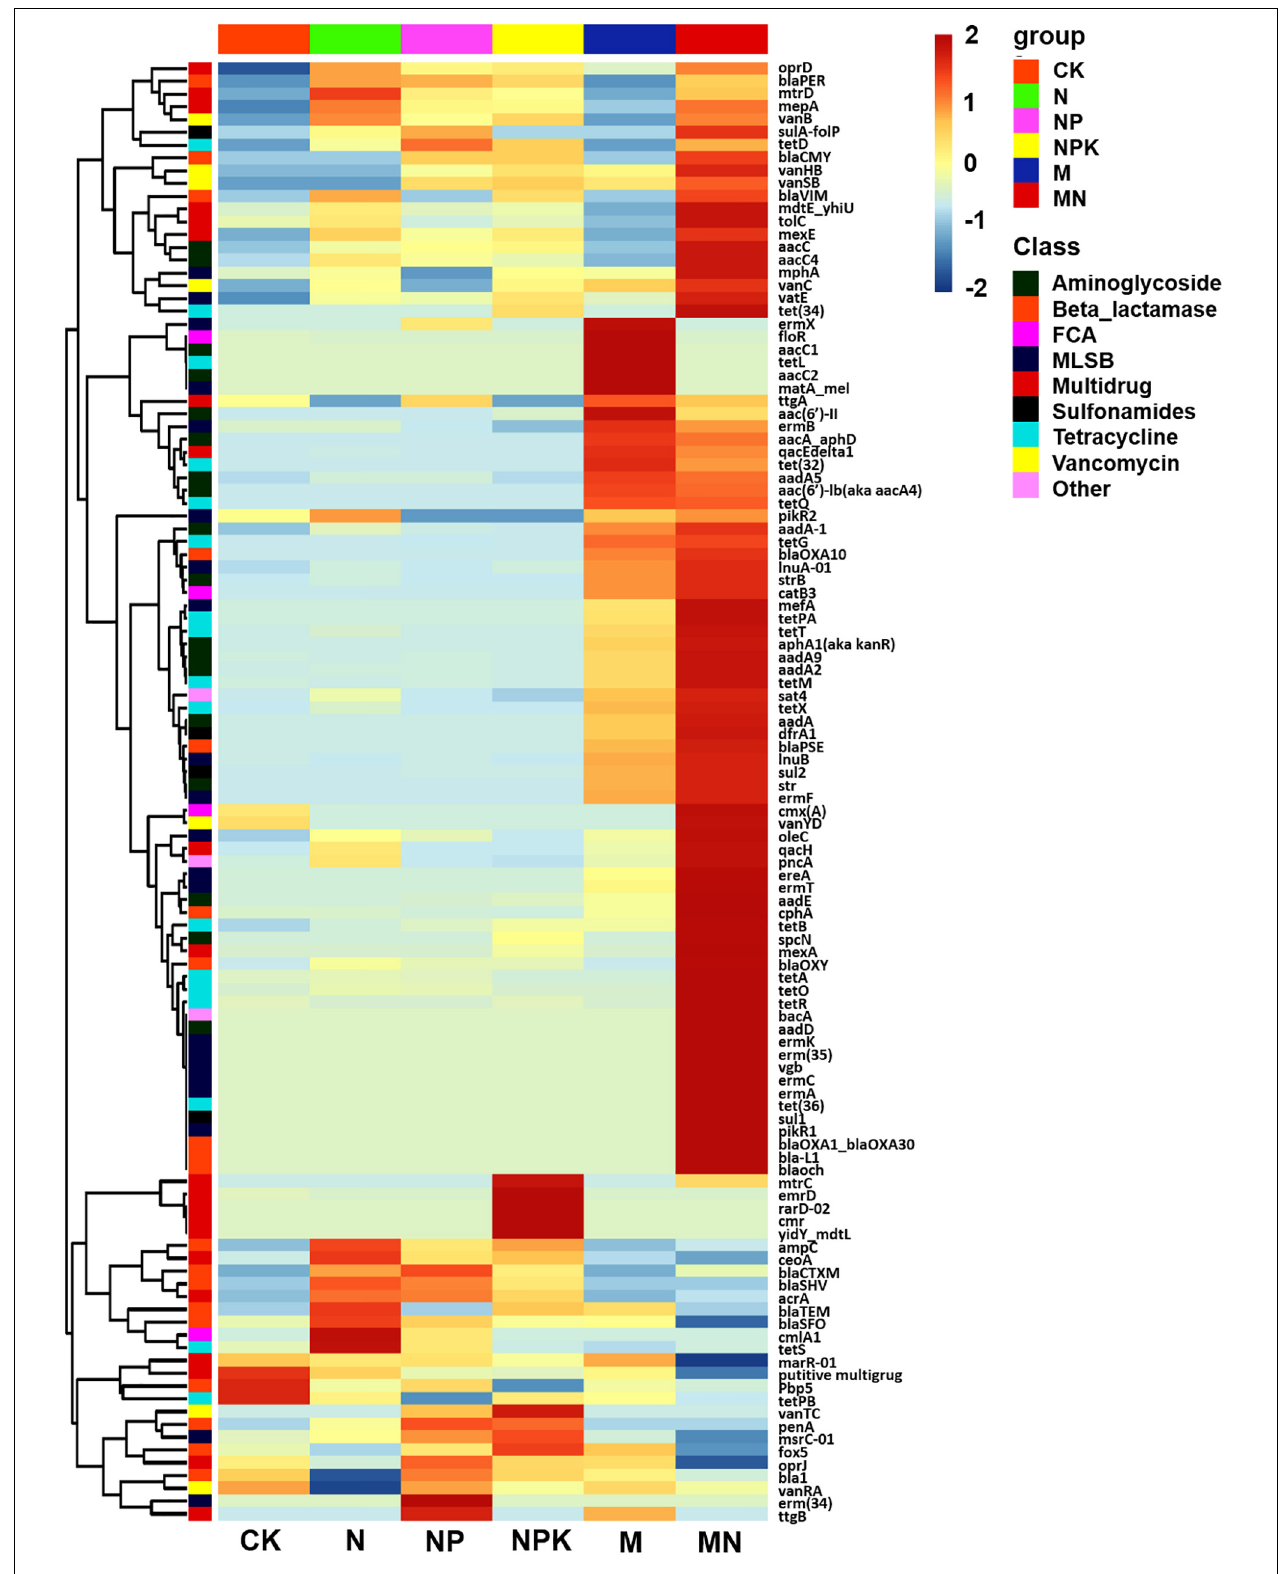
FIGURE 1 | Heatmap graph showing the profiles of ARGs in the different treatments. Each row represents a single ARG, and each column represents the soil treatment. Data were standardized using the absolute abundance of ARGs. FCA, fluoroquinolone, quinolone, florfenicol, chloramphenicol, and amphenicol; MLSB, macrolide-lincosamide-streptogramin